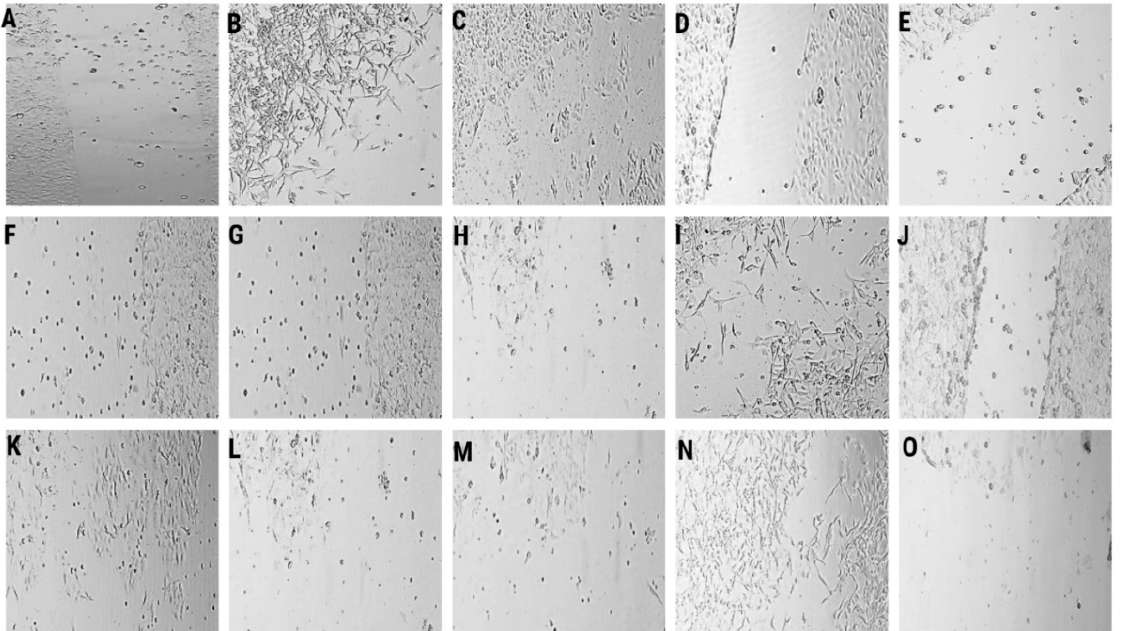
Figure 5. Representative microscopy images of transwell migration of U251 glioma cells over 1 day: control ( A ), under the action of NGF (7.55 × 10 − 3 μ M) ( B ), LL-37 (4 μ M) ( C ), PG-1 (16 μ M) ( D ), and TMZ (155 μ M) ( E ); over 2 days: control ( F ), under the action of NGF (7.55 × 10 − 3 μ M) ( G ), LL-37 (4 μ M) ( H ), PG-1 (16 μ M) ( I ), and TMZ (155 μ M) ( J ); over 3 days: control ( K ), under the action of NGF (7.55 × 10 − 3 μ M) ( L ), LL-37 (4 μ M) ( M ), PG-1 (16 μ M) ( N ), and TMZ (155 μ M) ( O ). Magnification ×100.